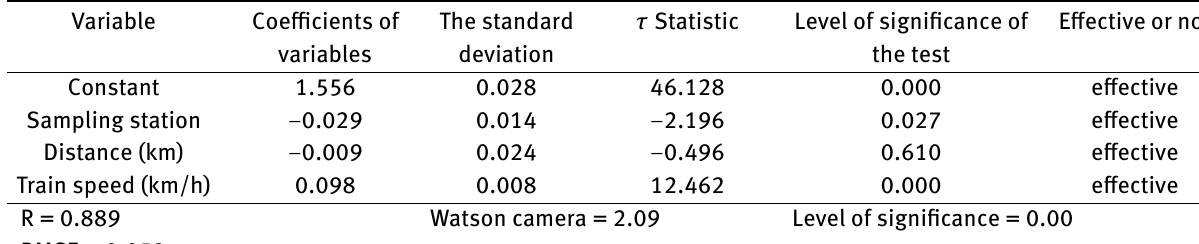
Table 4: Logarithmic regression